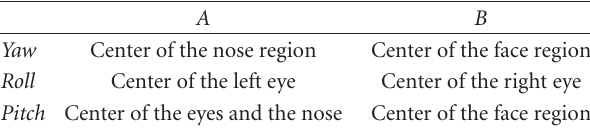
Table 5: Feature points of the face. A